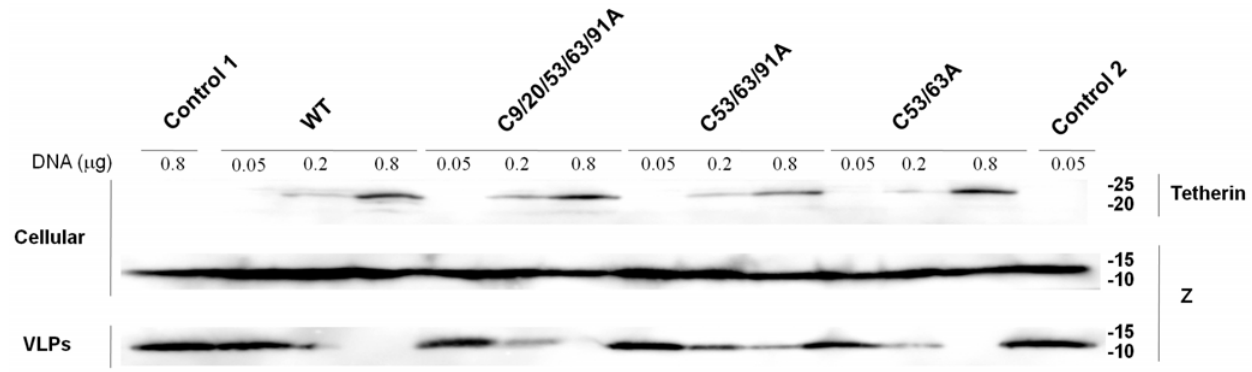
Figure 2. Dose-dependent reduction of VLP release at increasing expression levels of tetherin. COS-7 cells were transfected with 0.5 m g of the expression plasmid for Lassa Z, pCLV-Z, together with the empty vector (Control 1: 0.8 m g, Control 2: 0.05 m g) or 0.05, 0.2 and 0.8 m g of plasmid DNA for WT or mutant tetherin. VLP-associated and cell-associated Z were analyzed by Western blotting. WT and mutant tetherin expressed in COS-7 cells were analyzed under reducing conditions by Western blotting.